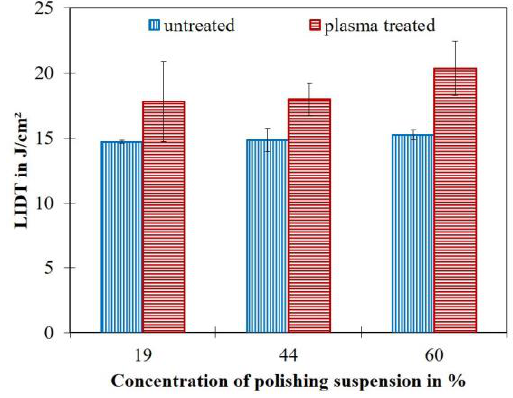
Fig. 2. Laser-induced damage threshold (LIDT) of zinc crown glass surfaces before and after plasma treatment; the samples were polished with different polishing suspension concentrations .